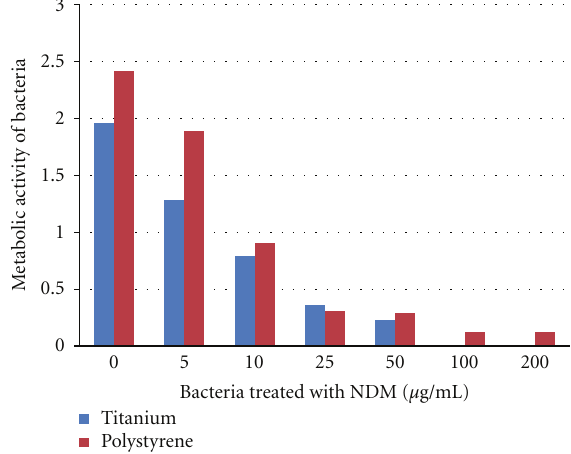
Figure 3: E ff ect of cranberry NDM treatment of S. gordonii on metabolic activity of biofilm formed on titanium and polystyrene surfaces. Bacteria treated with cranberry NDM for 4 hours were added to the titanium discs and in parallel to polystyrene 24- well culture dish. The metabolic activity of adherent bacteria was determined by XTT assay. Total biomass of biofilm bacteria was not significantly a ff ected by none of the indicated NDM concentrations as determined by crystal violet assay (data not